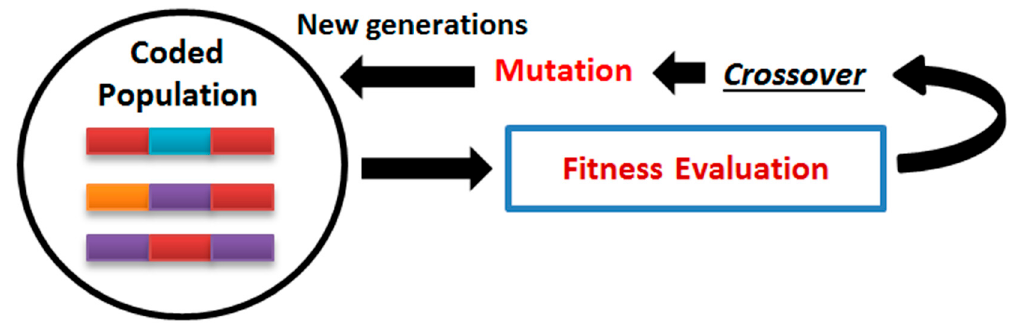
Figure 4. Solution flow in the genetic algorithms.